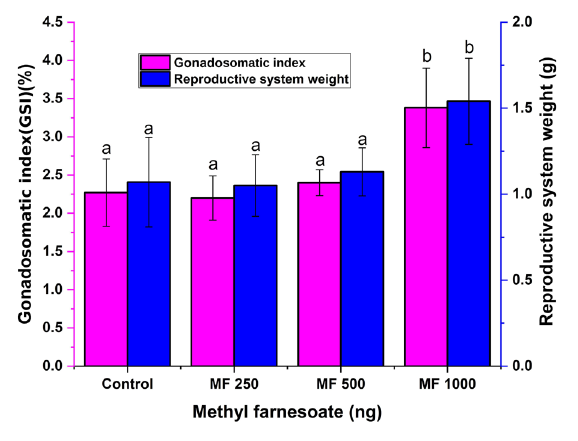
Figure 2. Effect of MF injection on reproductive system weight and GSI in male Pontastacus leptodactylus. Letters indicate significant difference groupings ( P < 0.05) (mean ± S.D; n =